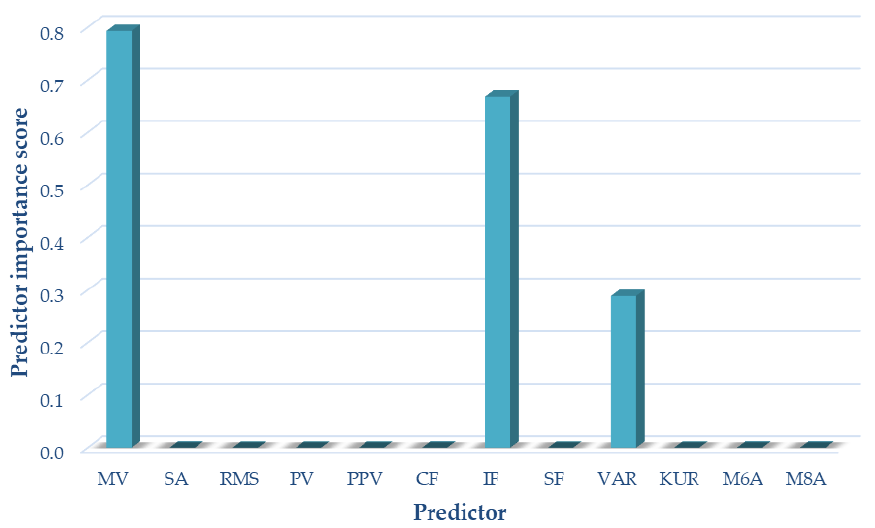
Figure 8. Selection of optimal features for variant III (OKC and CKC).